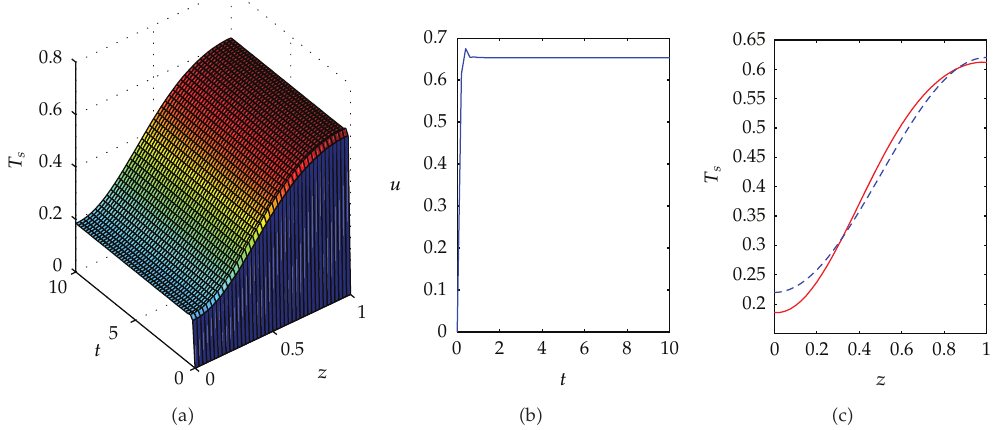
Figure 7: Controlled by a clustering and SVM-regression learning-based 3-D FLC under ideal situation (cid:3) dotted line: reference profile (cid:4) .